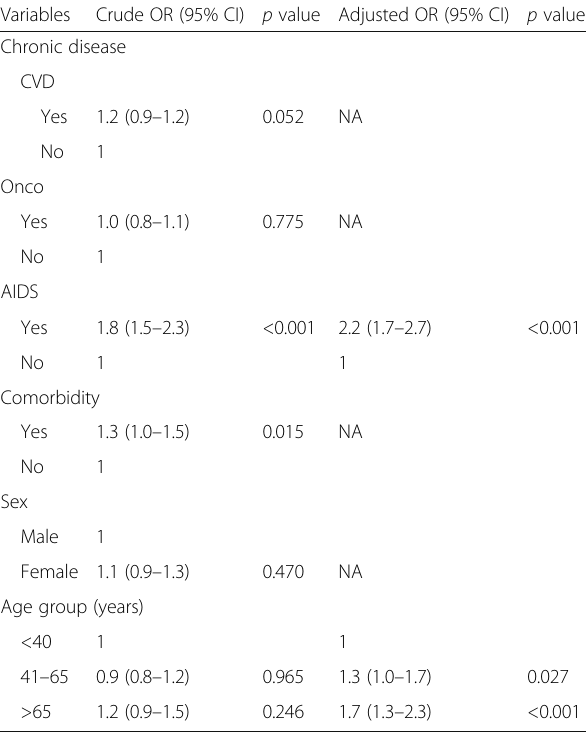
Table 3 Risk factors associated with death in population studied (univariate versus multivariate analysis)